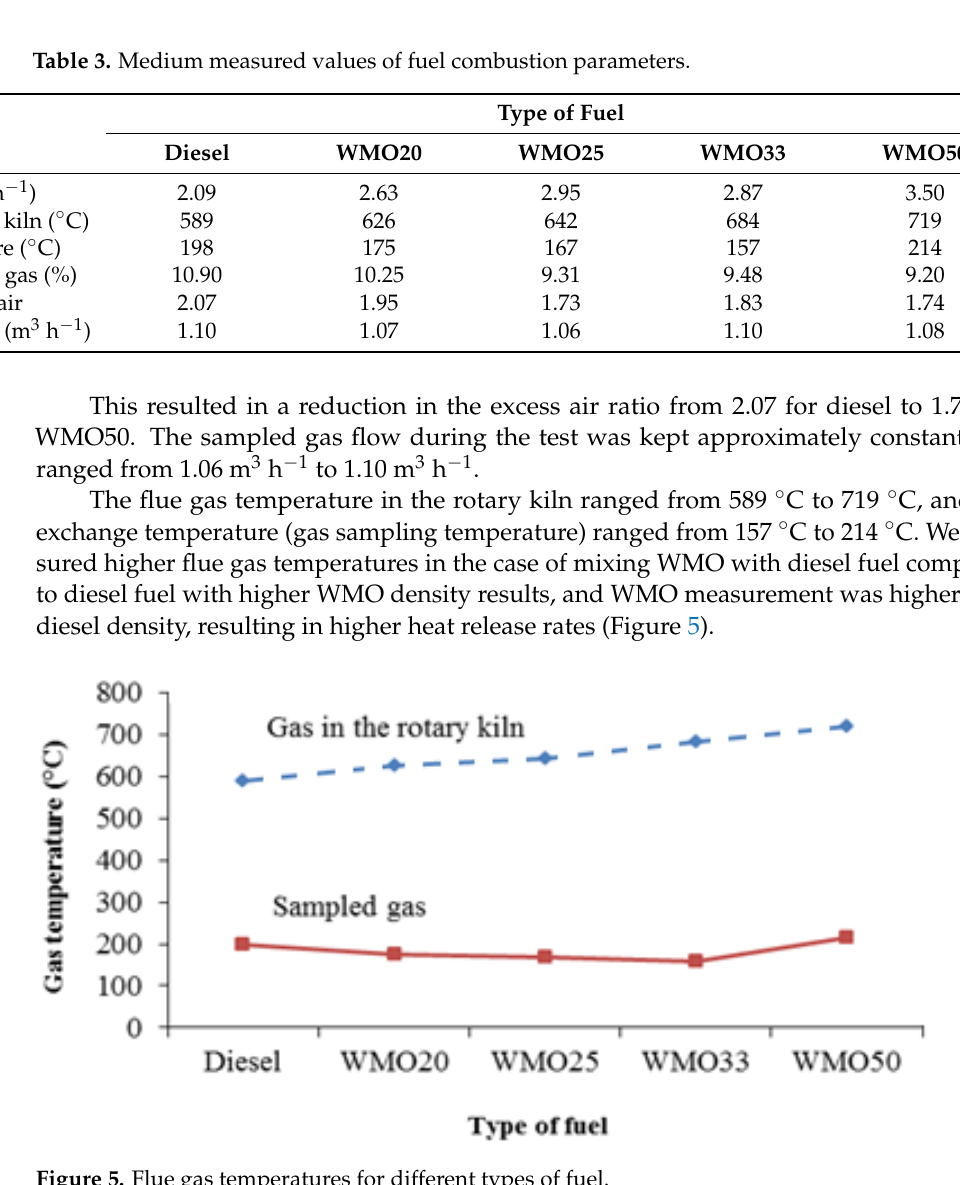
Figure 5. Flue gas temperatures for different types of fuel.